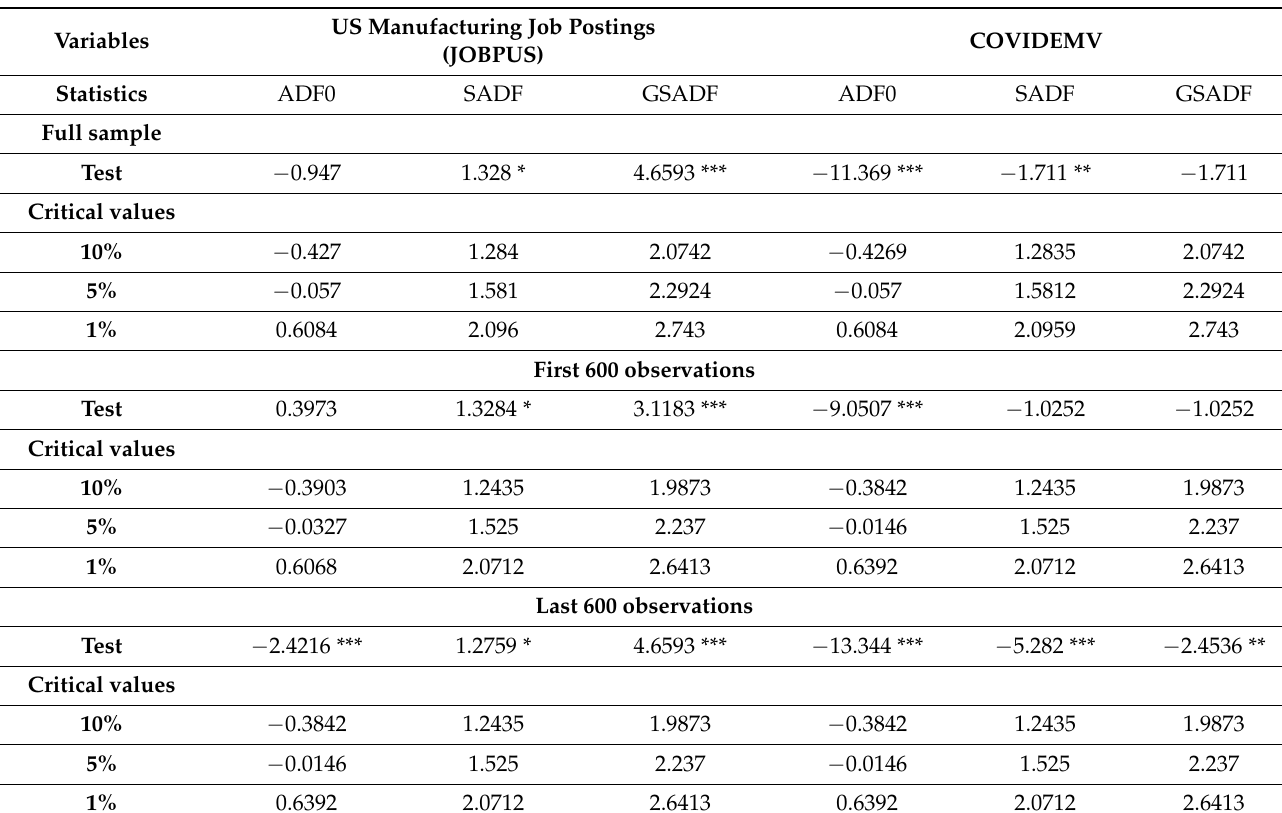
Table 2. Results of unit root tests with explosive behavior.